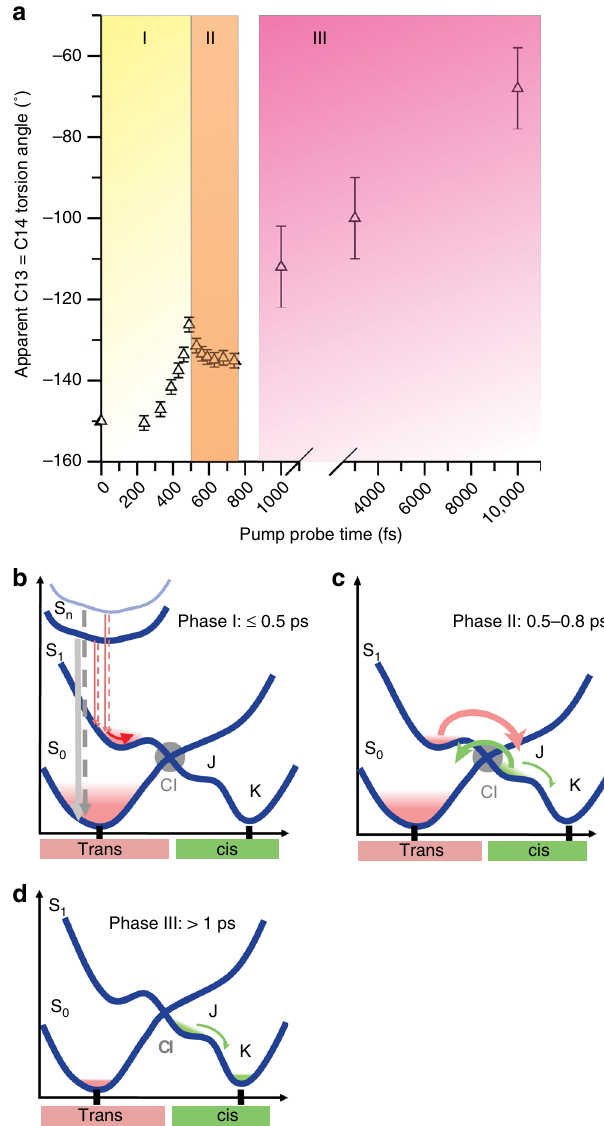
Fig. 7 Temporal evolution of the apparent C13 = C14 retinal torsion angle. The structural dynamics of the twisting bond can be divided into three distinct phases ( a ). b The fi rst (I, 0 – ~500 fs, yellow) re fl ects the initial torsional motion in S 1 after relaxation from multiphoton excited high energy states S n and internal conversion into S 0 . c During the second phase (II, ~500 – 750 fs, beige), the torsion angle decreases, indicating transition not only to the hot J state but also to a hot all- trans ground state. The small reduction of the dihedral angle is due to an average over the populated vibrationally hot distorted S 1 , the 13- cis J state and the all- trans ground state. The 0.5 – 0.8 ps timescale is consistent with the decay of the excited state (cf. “ spectroscopic characterization ” ). This is followed by phase III (1 – 10 ps, pink, d ) displaying the increase of the torsion angle, as expected for J and K state relaxation, ultimately yielding the relaxed 13- cis isomer of retinal. The error bars were derived as described in Supplementary Methods. Source data are provided for Fig. 7a as a Source Data fi